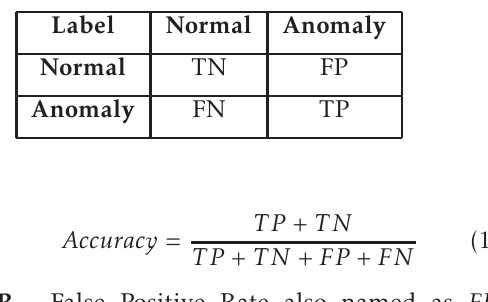
Figure 10. Taxonomy of anomaly in SCADA systems Table 3. Standard confusion metrics for evaluation of anomaly detection